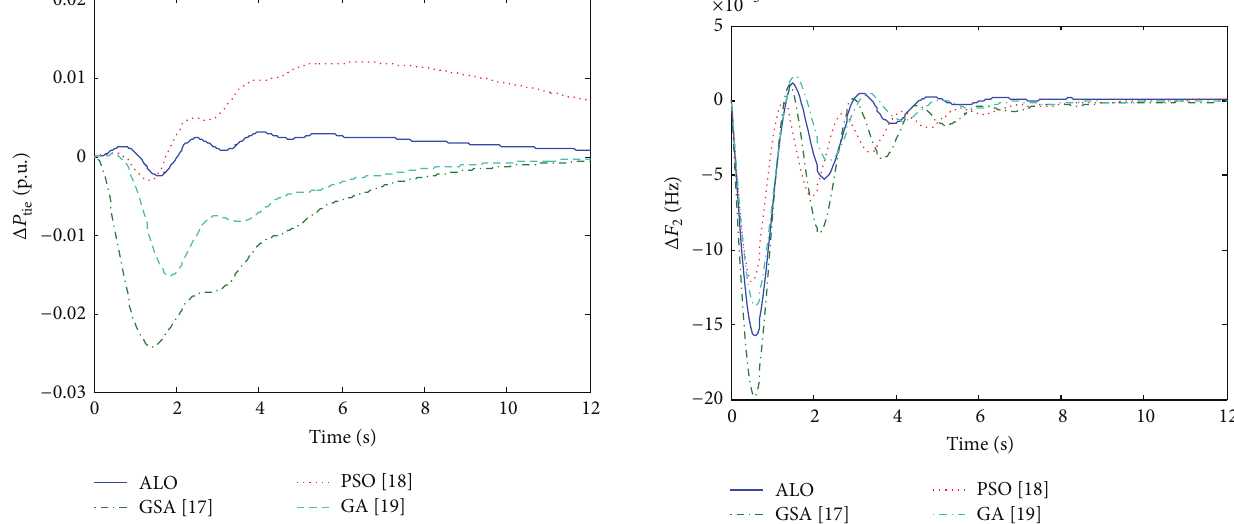
Figure 12: Change in tie-line power by 25% load increase in area 1.